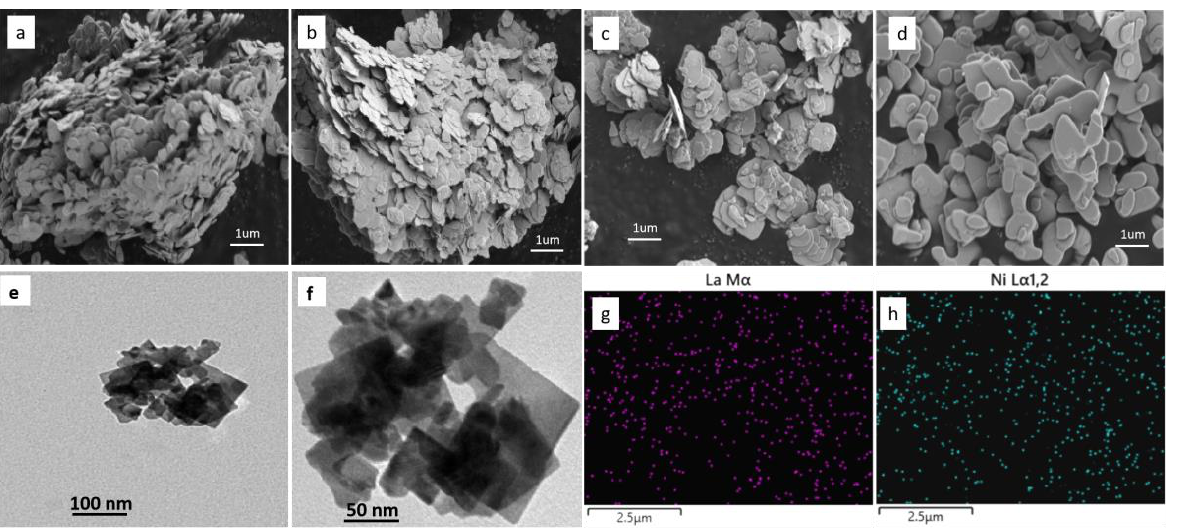
Figure 4. SEM micrographs of as-prepared photocatalysts: BiOCl ( a ), NiBiOCl ( b ), LaBiOCl ( c ), and LaNiBiOCl ( d ); TEM of LaNiBiOCl ( e , f ); and EDS of La and Ni in LaNiBiOCl ( g , h ).